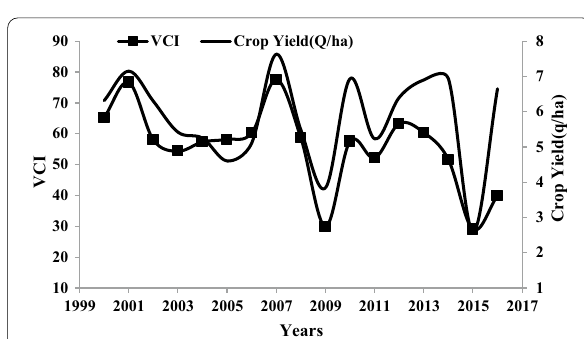
Fig. 10 Temporal trend of VCI and Crop Yield data (Q/ha)